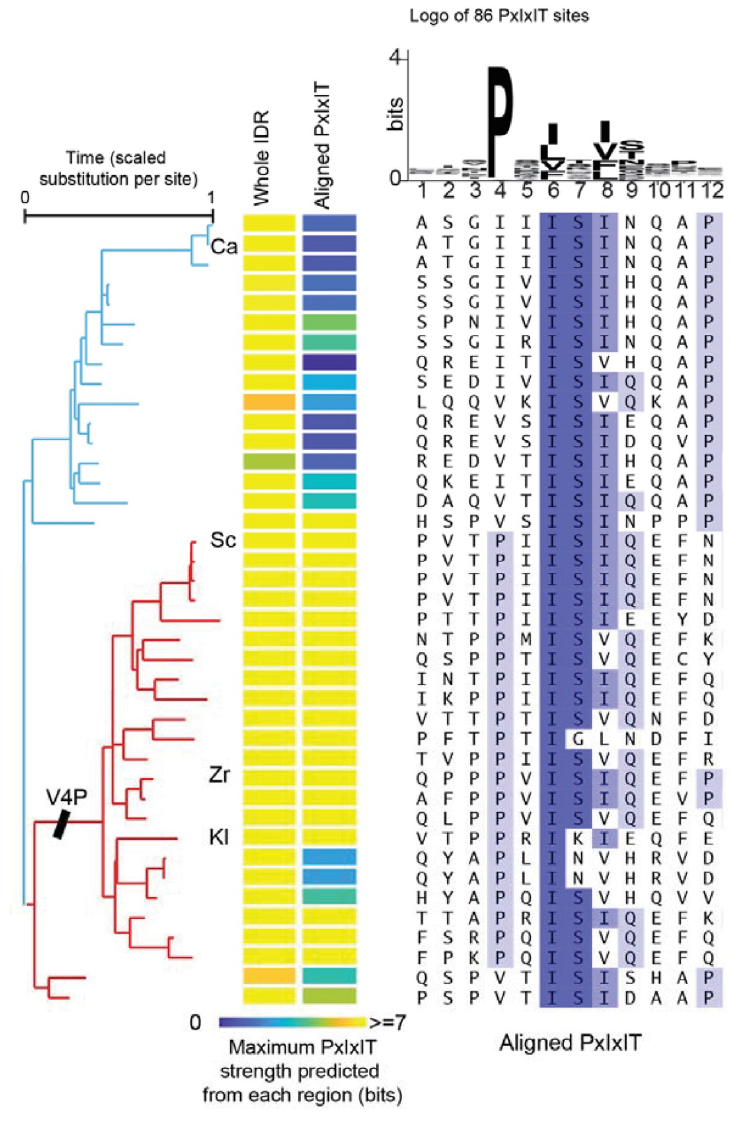
Fig 4. PxIxIT strength in the region homologous to the S . cerevisiae docking site is predicted to increase in the lineage leading to the Saccharomyces. The left heatmap represents the strength of the strongest PxIxIT site identified in the whole IDR. The right heatmap shows the predicted strength in the homologous region of the S . cerevisiae PxIxIT (shown in the alignment). The branch lengths of the phylogenetic tree are estimated by maximum likelihood based on alignments of the entire Crz1 protein. The label V4P indicates the branch where the inferred V4P substitution occurred. The alignment shows the 12 residues of 40 fungi. The logo represents the PSSM